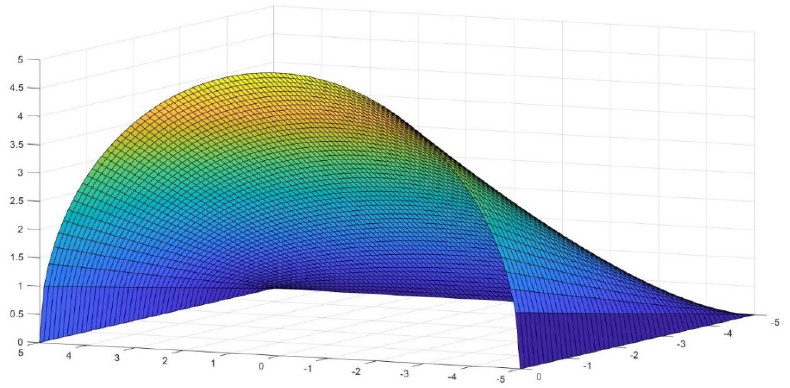
Figure 1. A typical straight conoid with circular directrix, where R = L = 5.